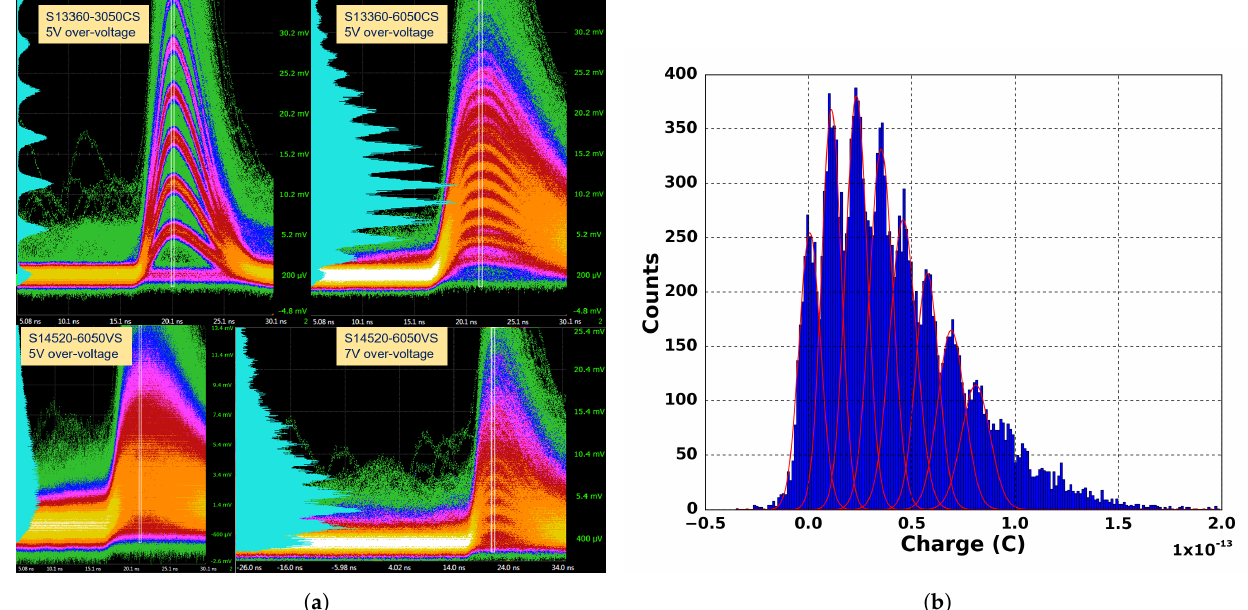
Figure 11. MUSIC individual channel analog response for different SiPMs with PZ cancellation at low level illumination. ( a ) Analog output pulses and peak amplitude histogram for the Hamamatsu SiPMs S13360 − 3050CS, S13360 − 6050CS and S14520 − 6050VE at different over − voltages. ( b ) Charge histogram of the Hamamatsu SiPM S14520 − 6050VE at 5V of over −